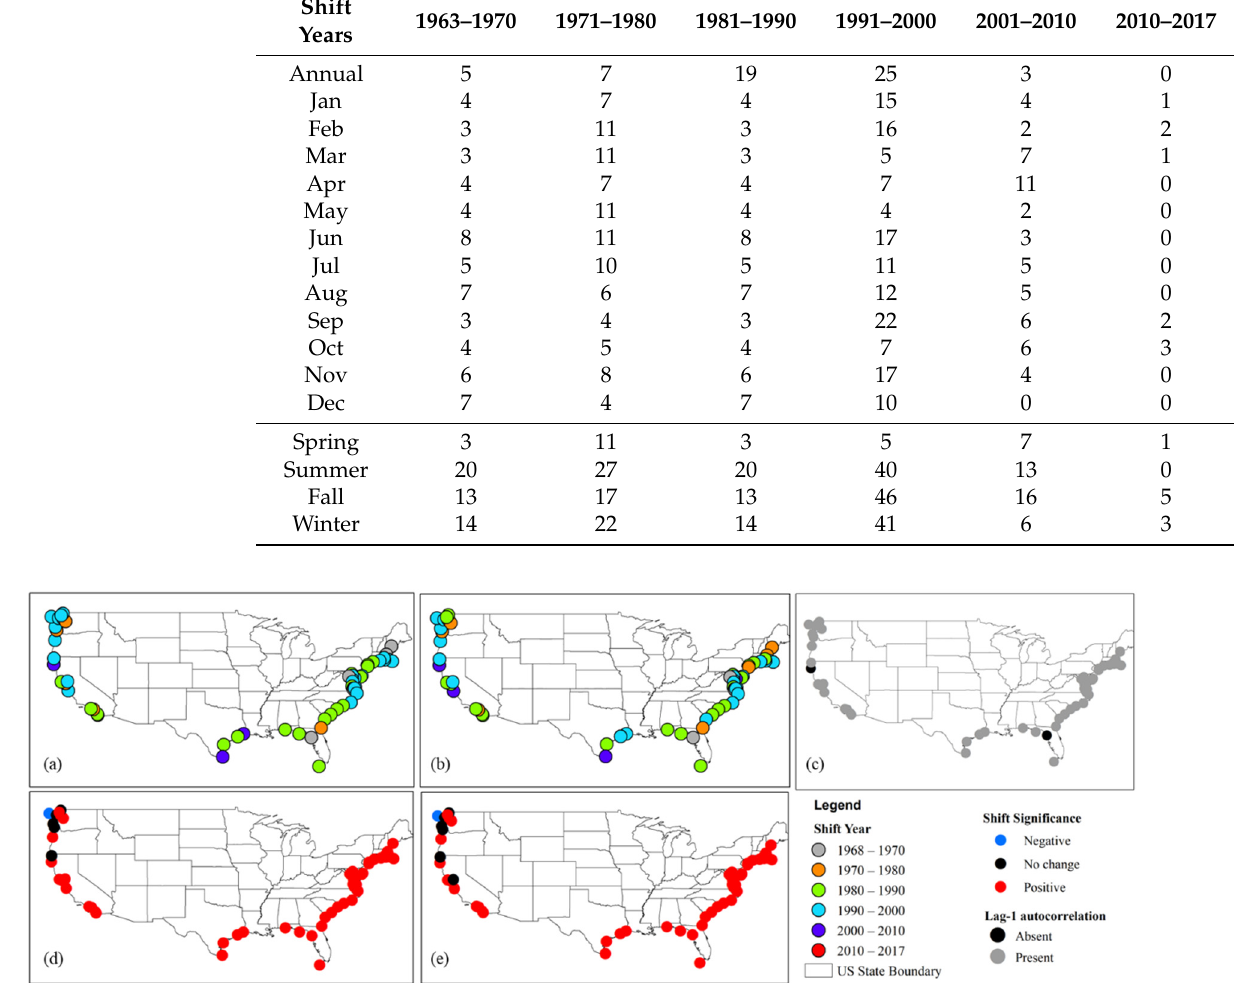
Table 2. Number of stations in different months at different time intervals and four seasons show- ing shifts. Shift Years